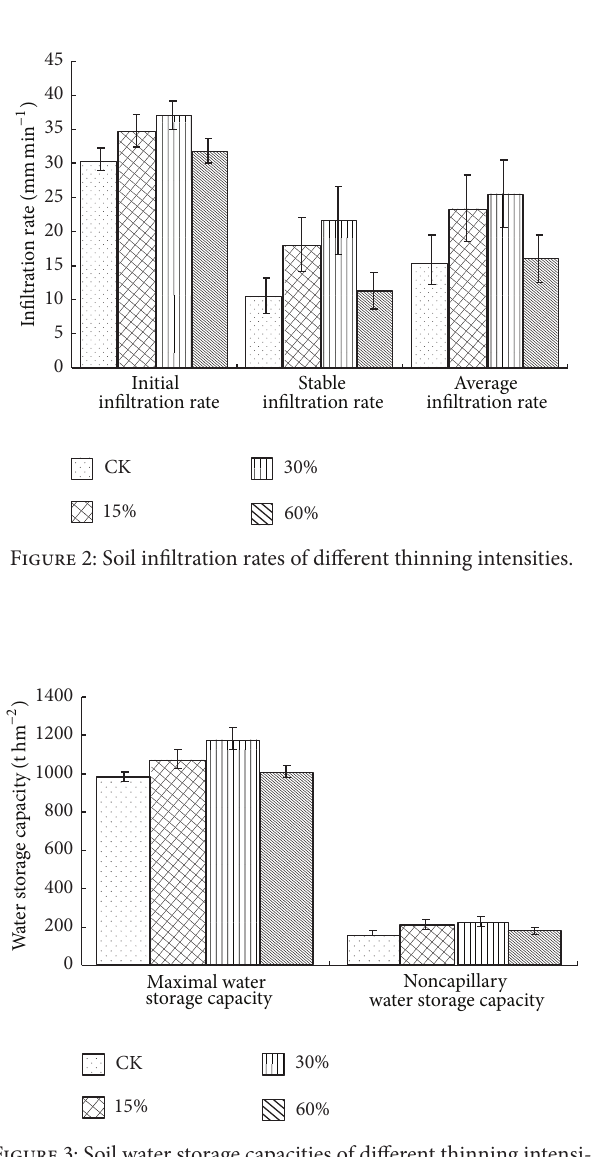
Figure 3: Soil water storage capacities of different thinning intensi-